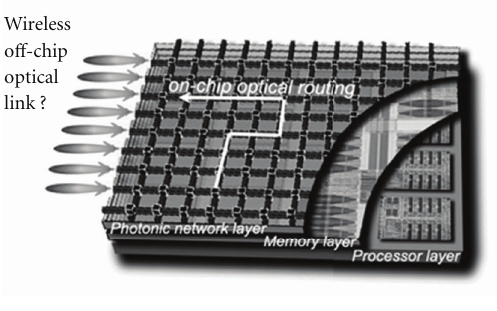
Figure 1: A concept of using directional nanoantennas as means of providing wireless on-chip and intrachip communication. Photo is modified from